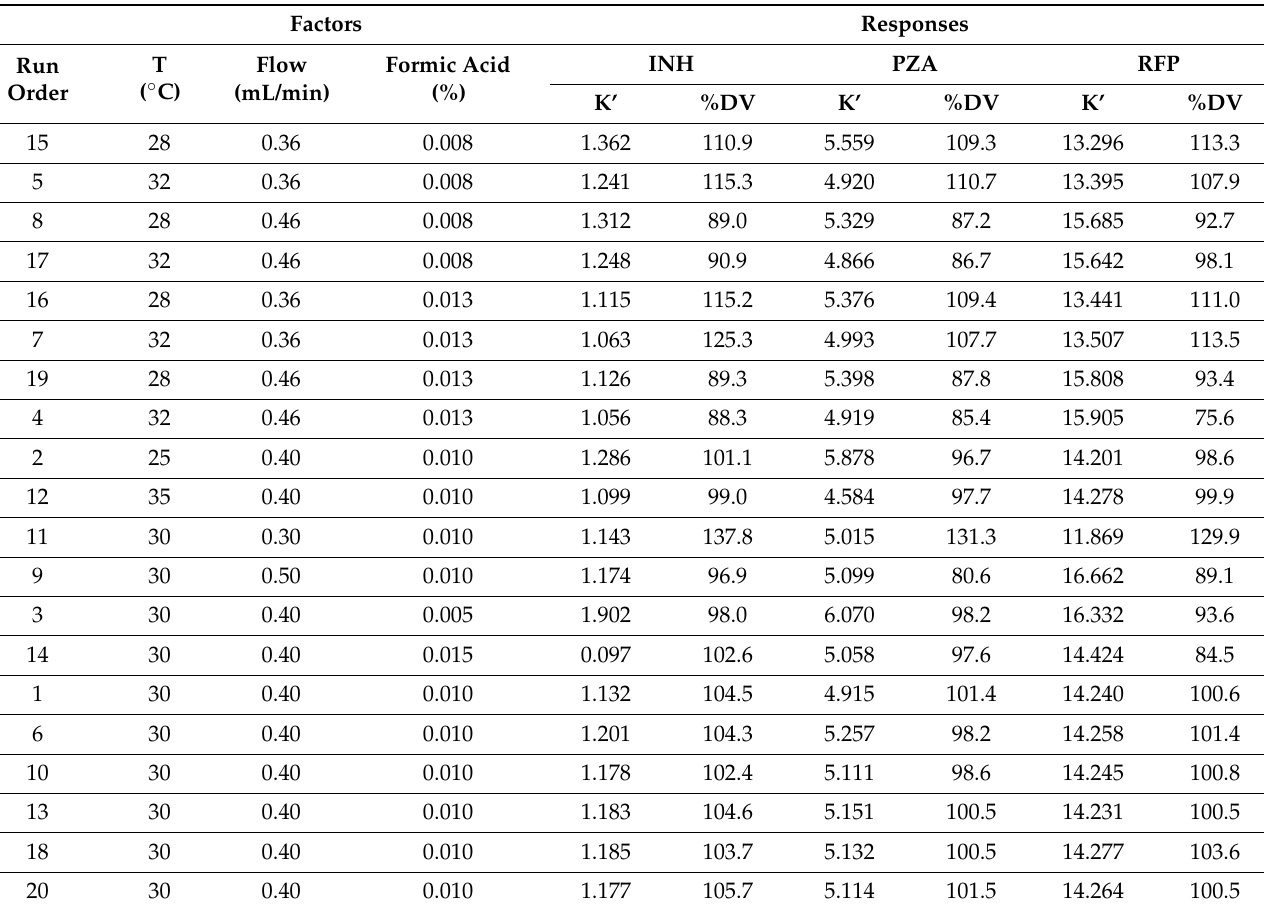
Table 1. Factors used for the estimation of the robustness based on the central composite design and responses, retention factor (k’), and amount of API expressed as the percentage of the declared value (DV). T: